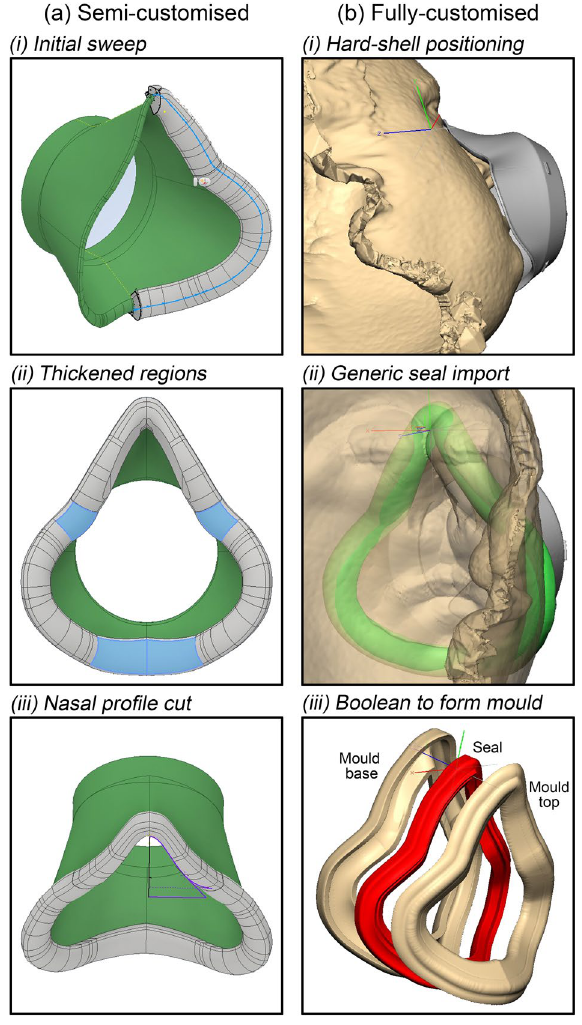
alignment and offset of the hard-shell from the facial scan data (ii) import of a generic seal, and (iii) formation of the